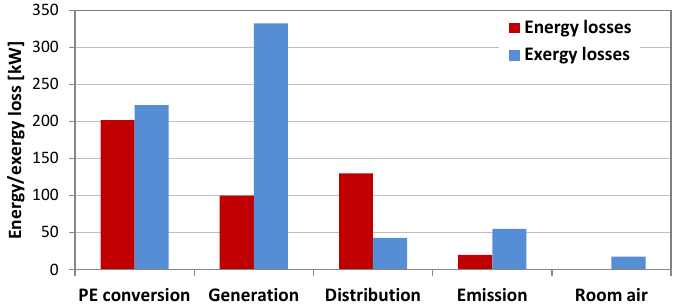
Figure 5. Energy and exergy losses in the single components [21].